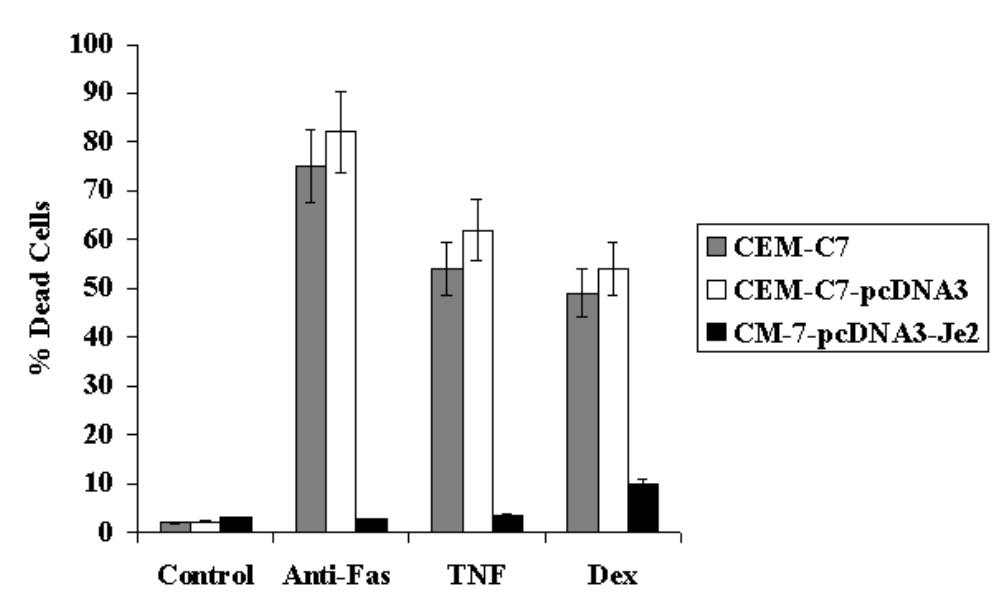
FIGURE 1 . Je2 over-expression inhibits CD95-, TNF α -, and dexamethasone- mediated cell death. CEM-C7 cells were stably transfected with pcDNA3 vector alone or pcDNA3-Je2. Cells (2 × 10 5 cells/ml) were incubated in the presence of 5 ng/ml anti-CD95, TNF α 50 ng/ml, and dexamethasone 10 µM for 48 h. The percentage of dead cell number was determined by nigrosin dye exclusion.